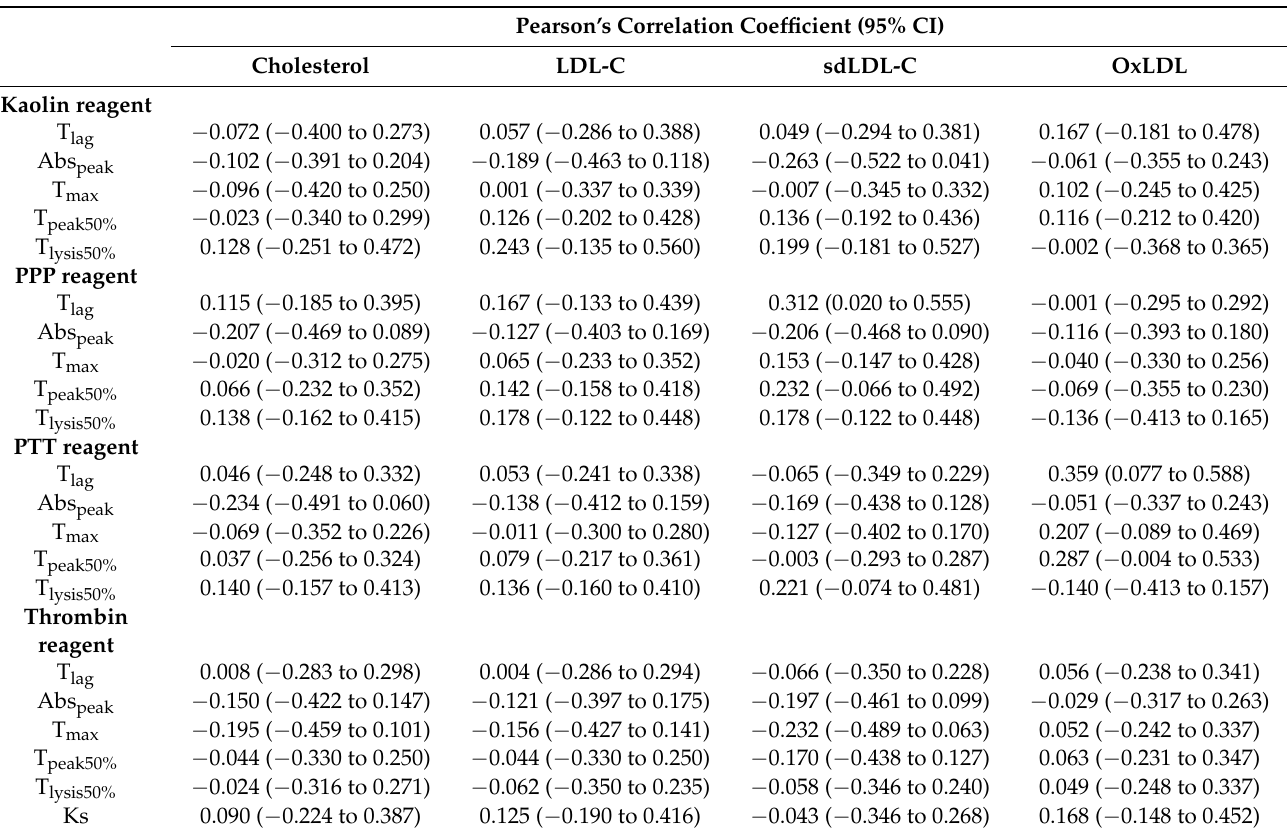
Table 7. Correlation between fibrin clot properties and lipoprotein distribution in whole plasma of patients with atrial